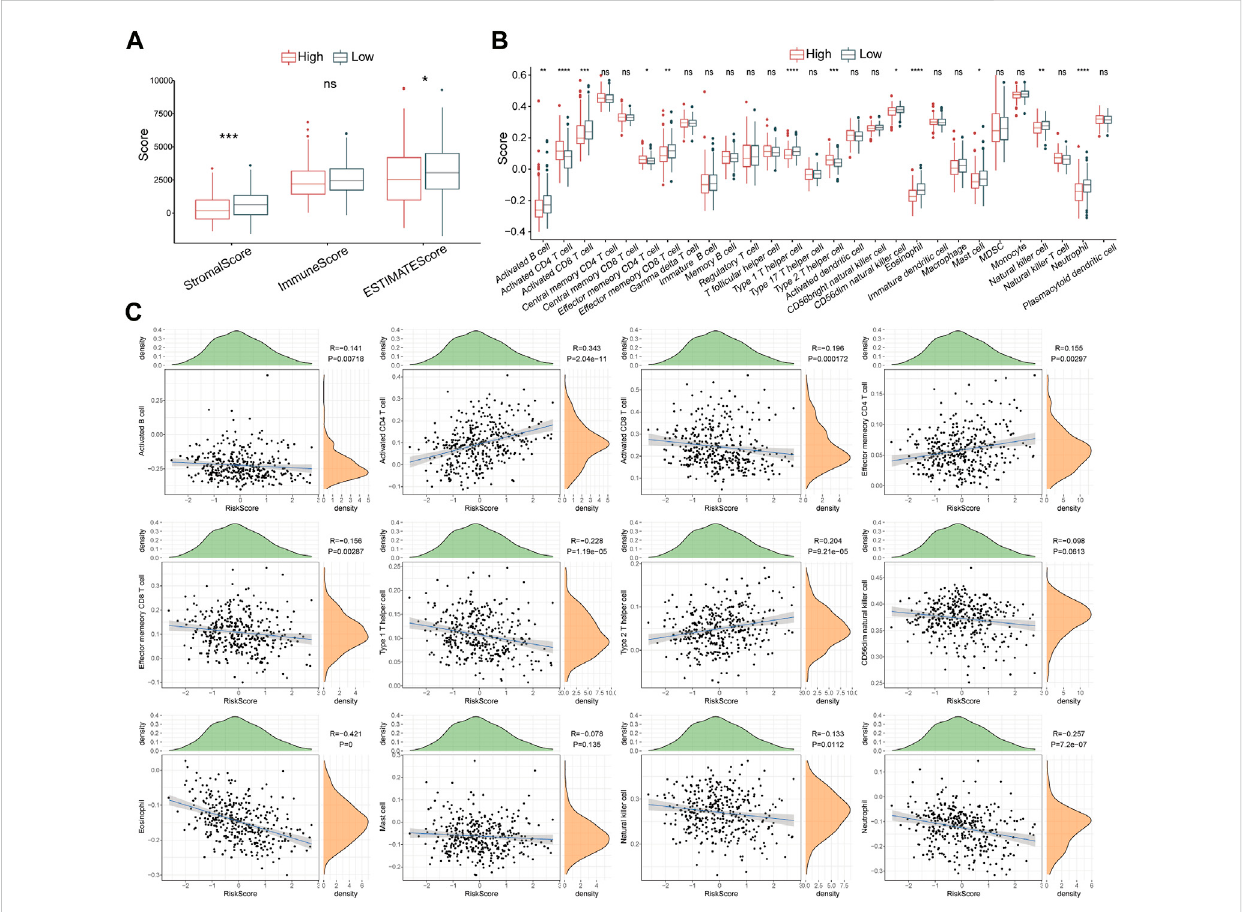
FIGURE 7 Immune characteristics of the risk model. (A) The Stromal score, Immune score, and ESTIMATES score in high- and low-risk groups. (B) The enrichment scores of 28 immune cells in high- and low-risk groups (C) Scatter plots display the correlation between risk score and 12 immune cells. ns, no signi fi cance, * p < 0.05, ** p < 0.01, *** p < 0.001, and **** p <